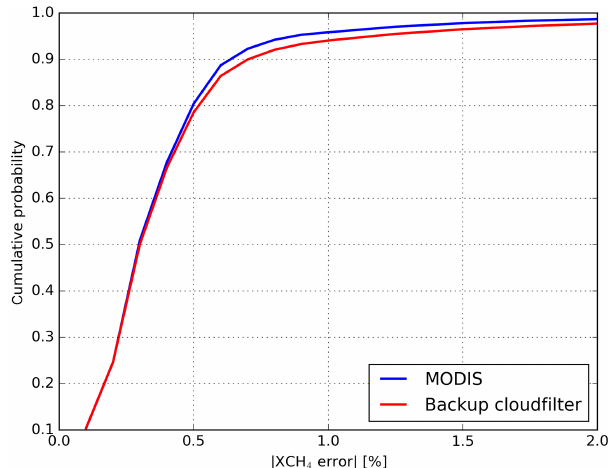
Figure 10. Cumulative probability distribution of the absolute XCH 4 bias for the simulated level 1b orbit. Cloud-contaminated measurements are filtered using MODIS data (blue line) or the backup cloud filter (red